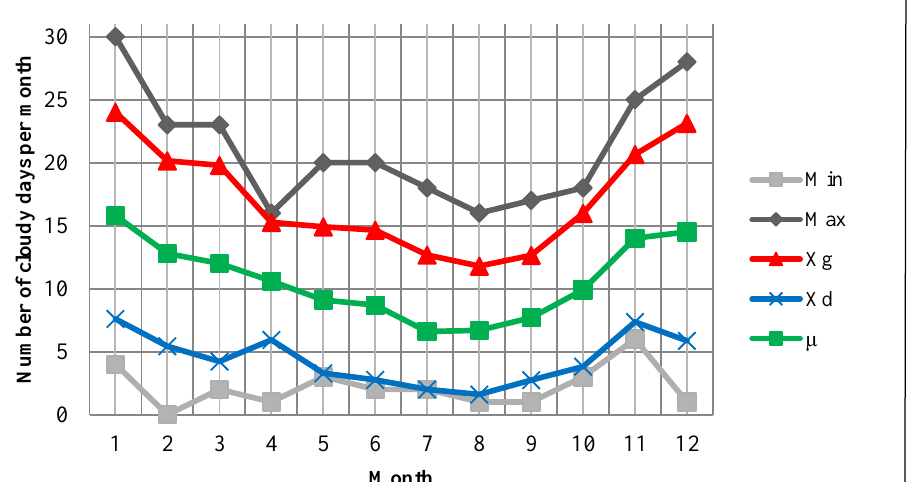
Figure 6 – Number of cloudy days per month (Min – Max) and the number of cloudy days interval around the average value with a 50% outcome